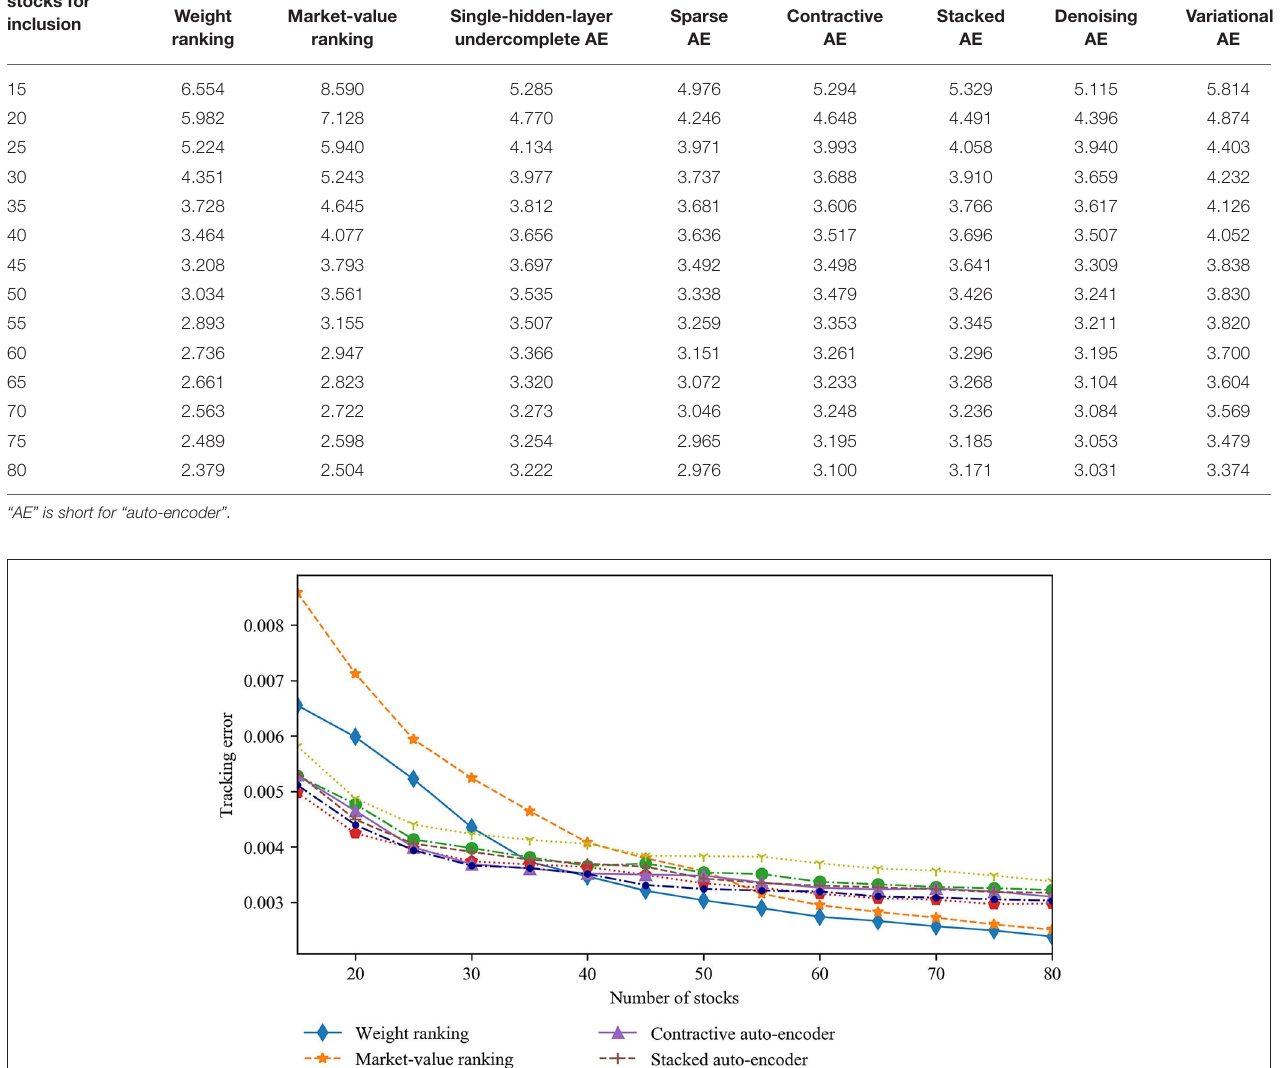
TABLE 1 | Out-of-sample tracking error values ( × 10 − 3 ) for all strategies covered by this study. Number of stocks for